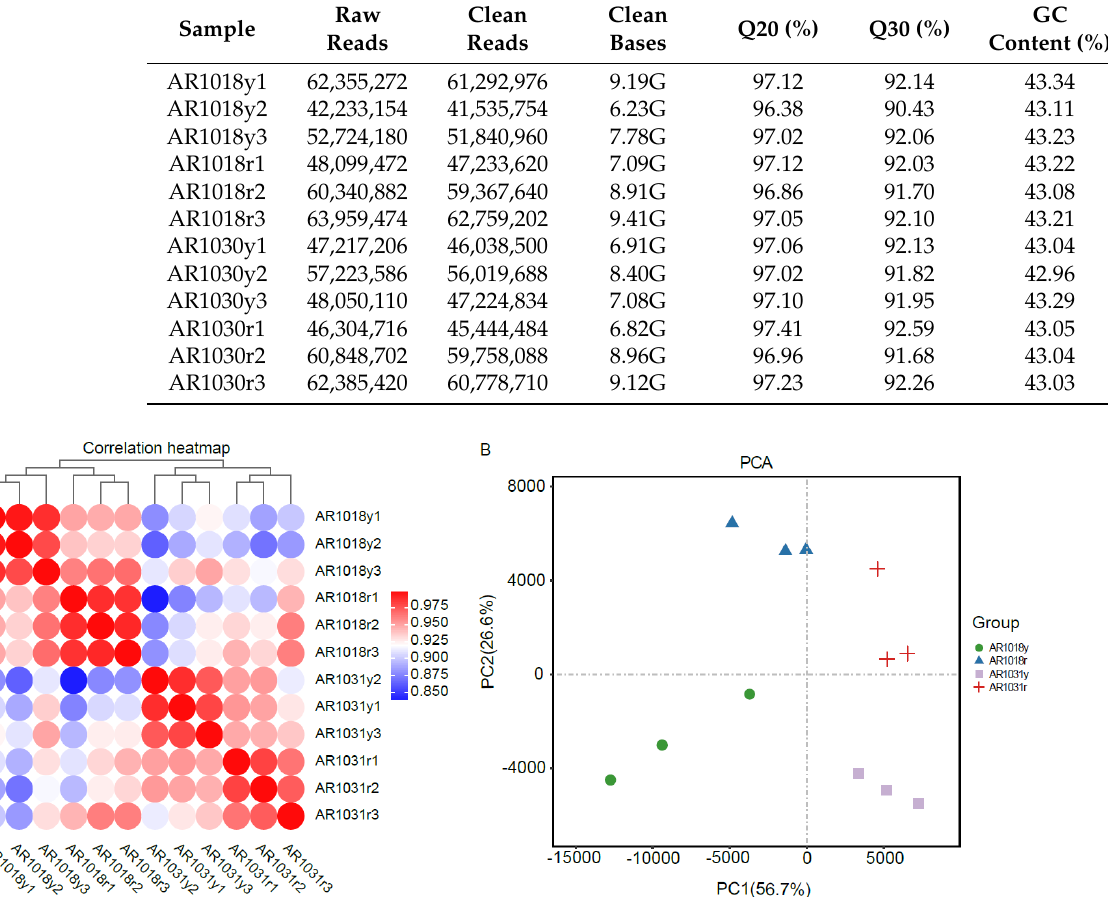
Figure 6. The Pearson correlations between each sample ( A ) and principal component analysis of red maple leaves ( B ). maple leaves ( B Table 1. Statistical analyses and mapping results of RNA sequencing reads.